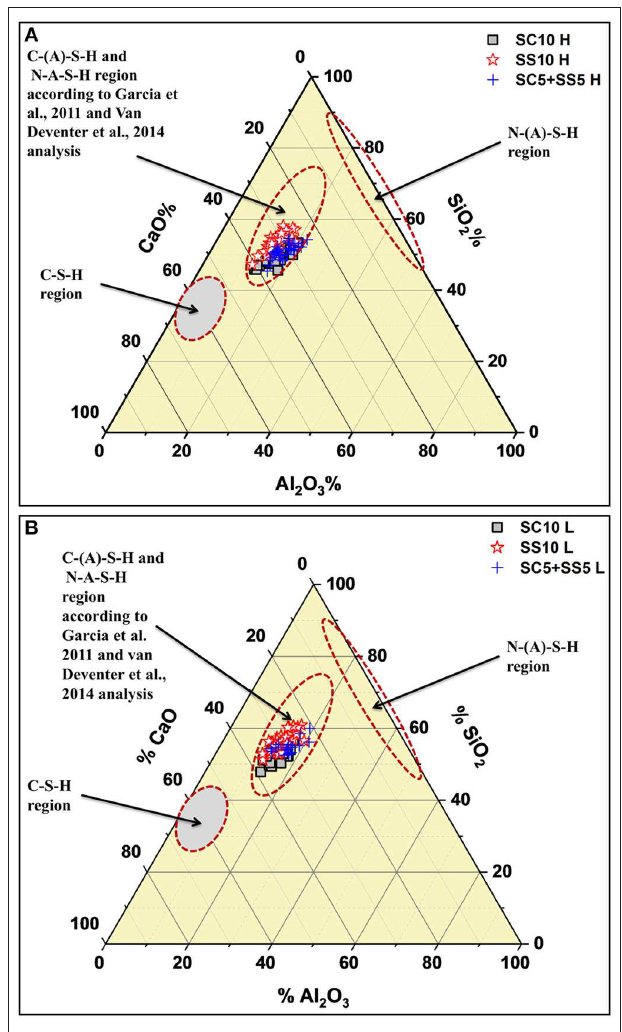
FIGURE 10 | Ternary diagrams showing the oxide composition regions of the sealed AAS concretes (28 days old) measured with SEM/EDX and compared with ( Garcia-Lodeiro et al., 2011; Van Deventer et al., 2014) results; (A) for heat-cured samples, (B) for lab-cured